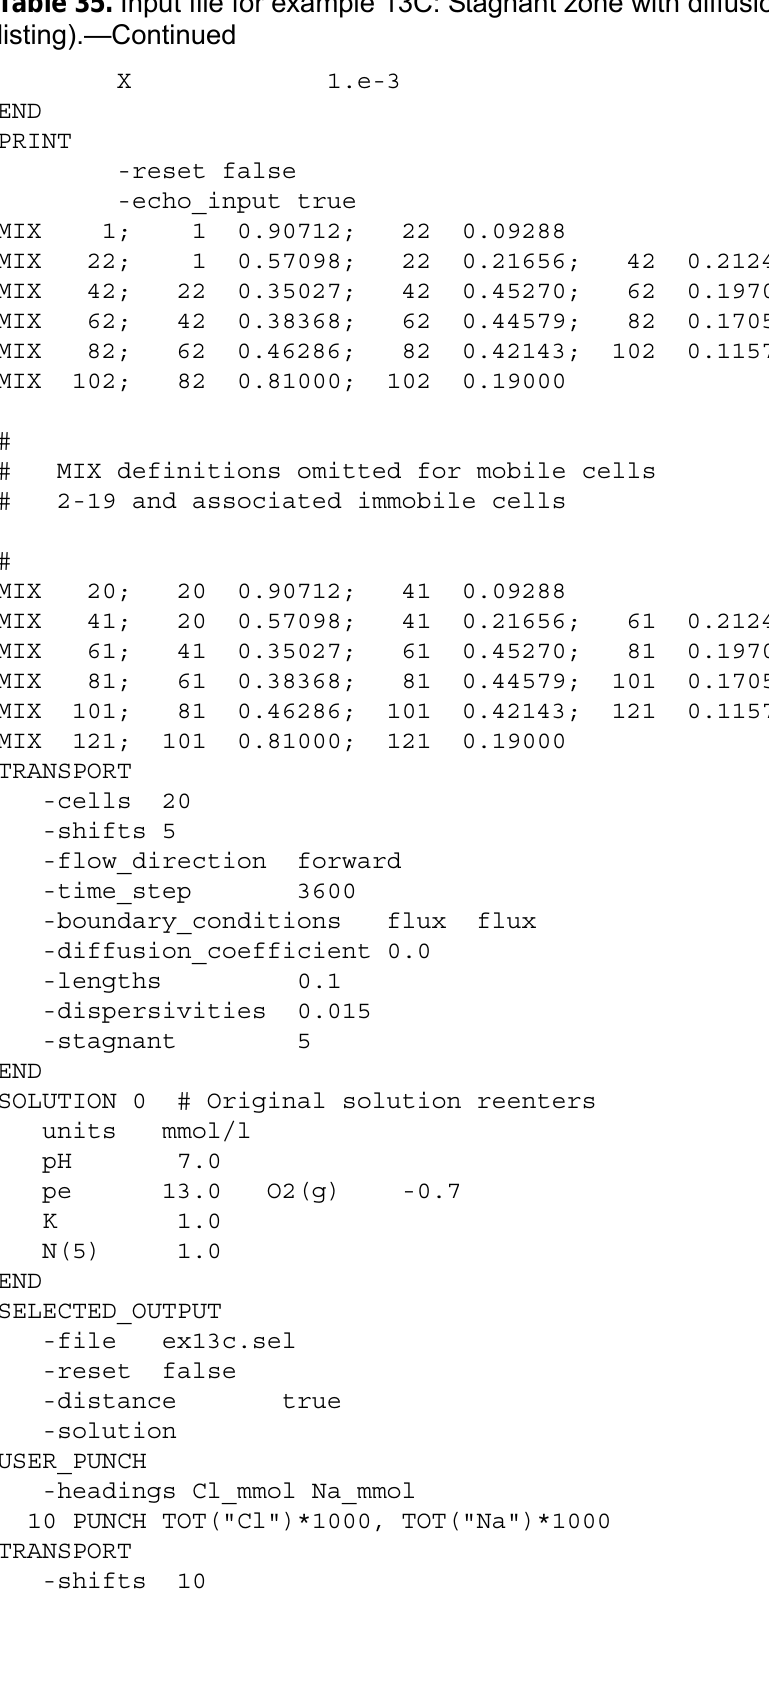
Table 35. Input file for example 13C: Stagnant zone with diffusion calculated by finite differences (partial